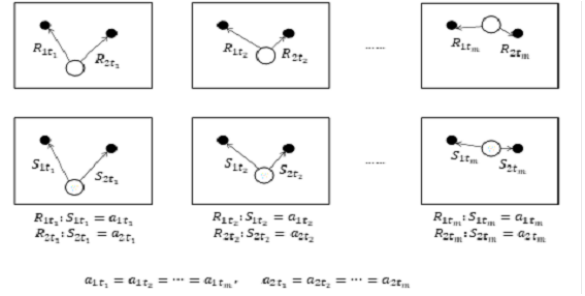
Fig. 2 The calculation process of E X in the track